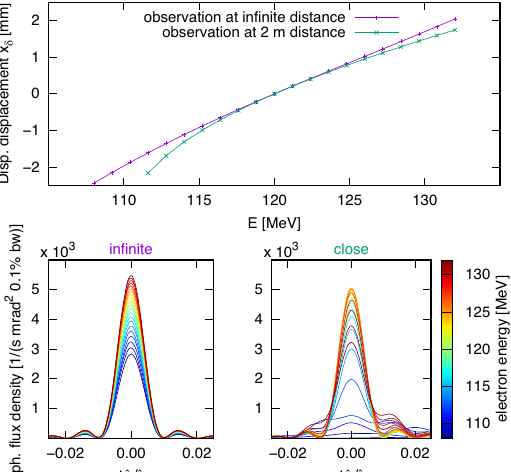
FIG. 8. Comparison of the optimized spectral dispersion of the electron beam and resulting radiation spectra for an observation point in infinite and 2 m distance, respectively.